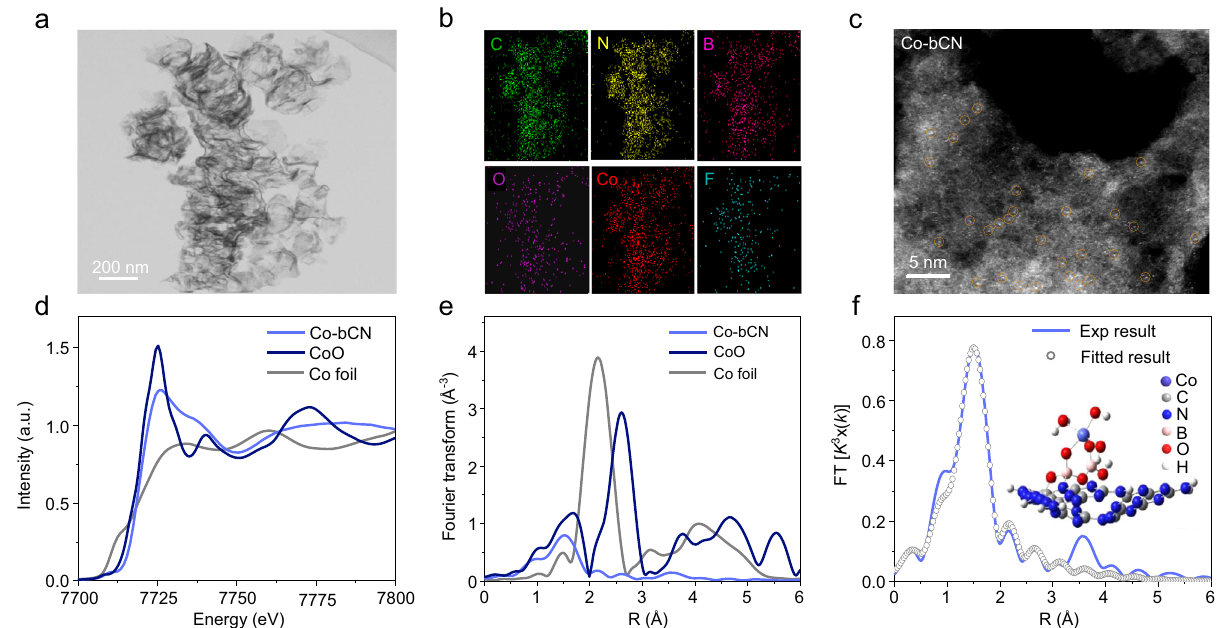
Fig. 3 | Characterization of IL/Co-bCN and Co-bCN. a TEM image of IL/Co-Bcn. b The corresponding EDXmapping images of elementalC, N, B,O,Co,and F of IL/ Co-bCN. Scale bar: 200nm. c The HAADF-STEM image of Co-bCN. Note: dots in orange circles indicate single Co atoms. Scale bar: 5 nm. d Normalized XANES